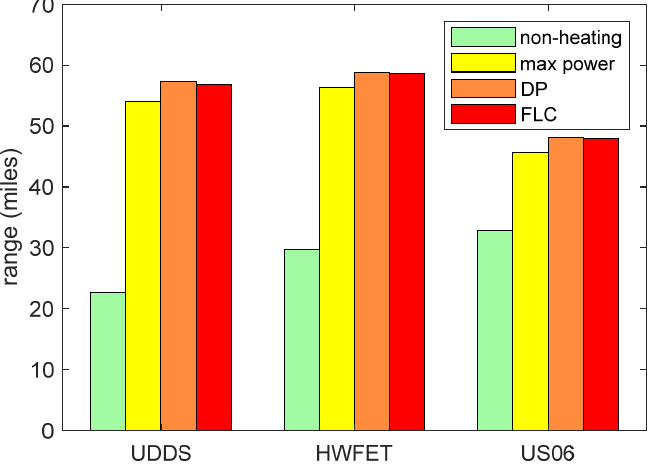
Figure 14. EPA driving cycle tests with initial cell temperature of − 30 °C and initial SOE of 30%.